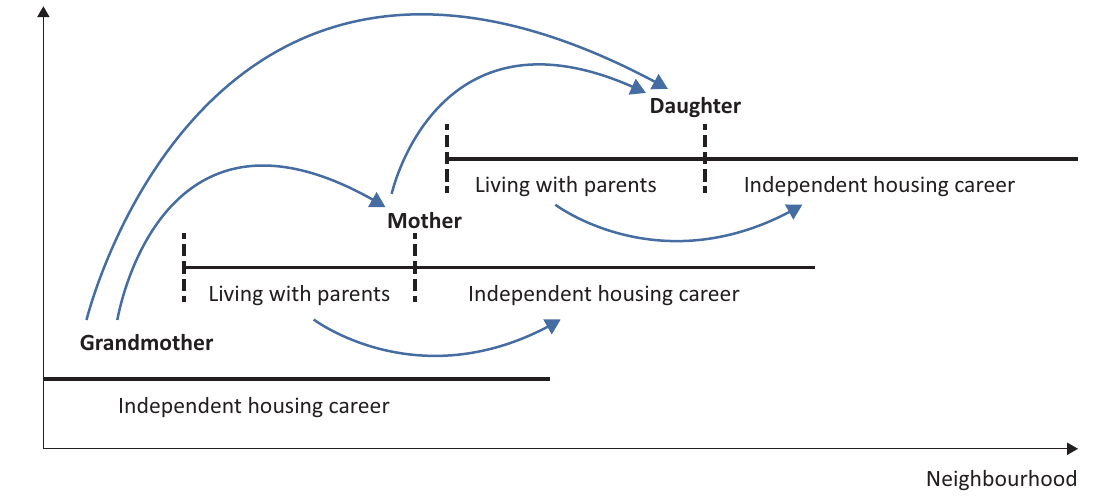
Figure 1. The linked lives across three